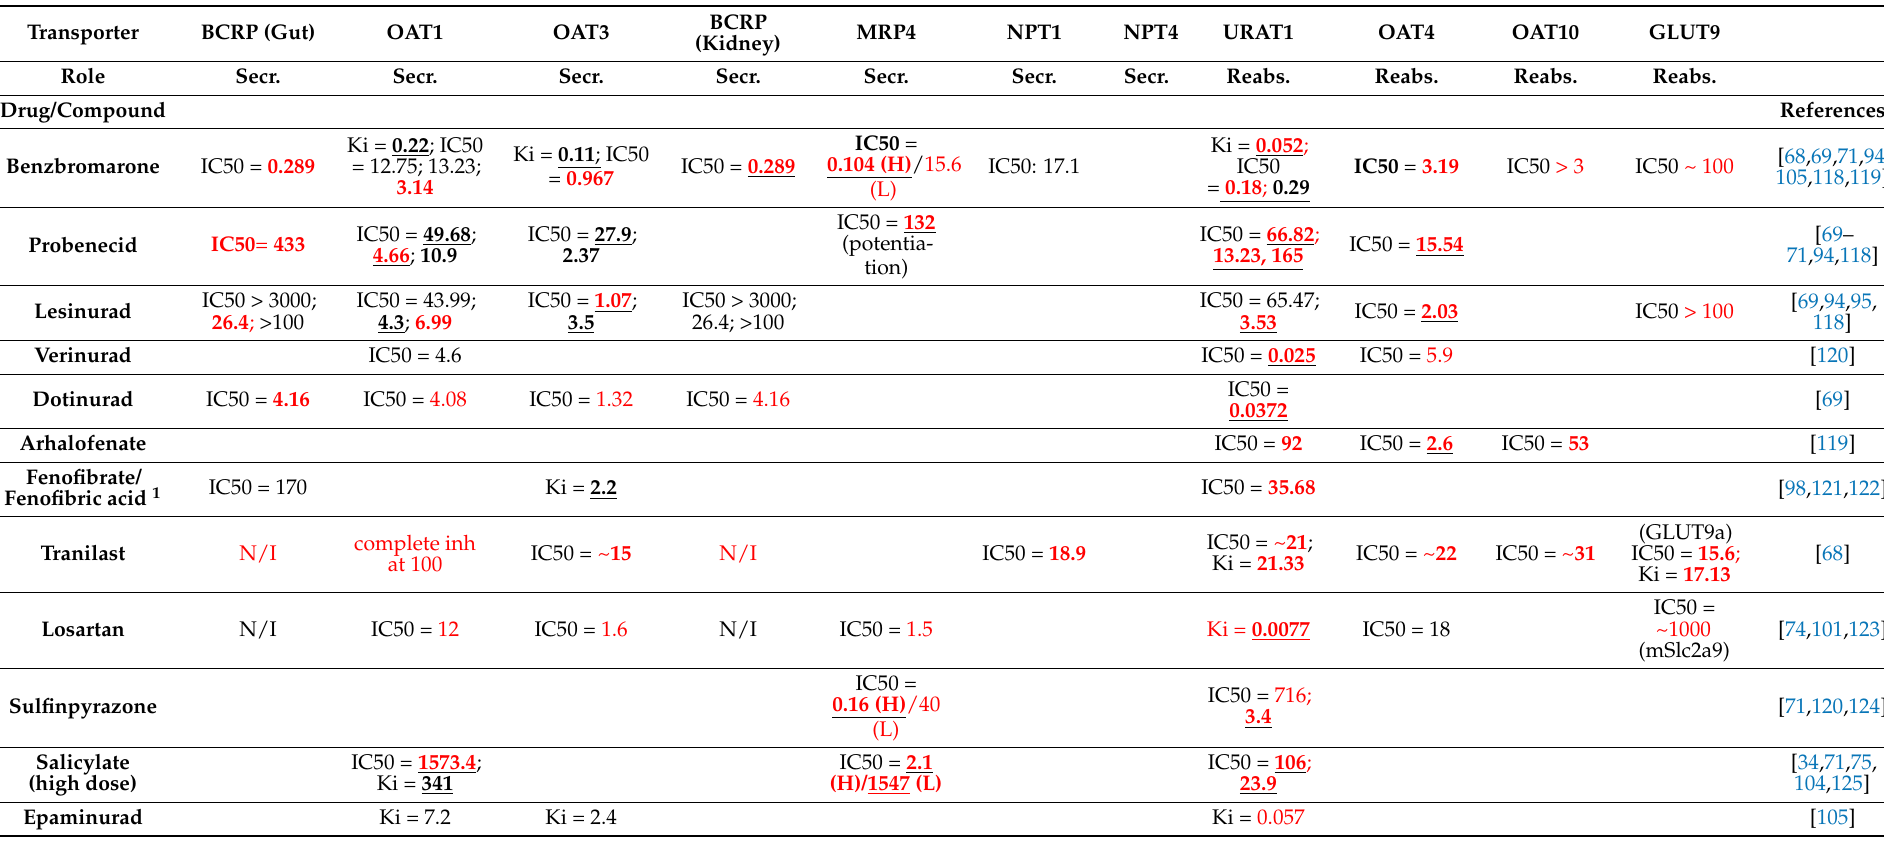
Table 3. Inhibition of urate transporters by drugs with a clinically observed uricosuric effect. Interactions were predicted to be clinically significant based on the following cut-off values: for intestinal BCRP, R = 1 + C gut /(IC 50 or K i ) ≥ 11 (shown in bold ); for renal transporters, C max,u /(IC 50 or K i ) ≥ 0.02 (shown in bold only) or ≥ 0.1 (shown in bold and underlined ). Values in red were obtained using urate as a probe substrate. For each drug/transporter pair, results from different studies are separated by semicolons. All values are in µ M. Abbreviations: